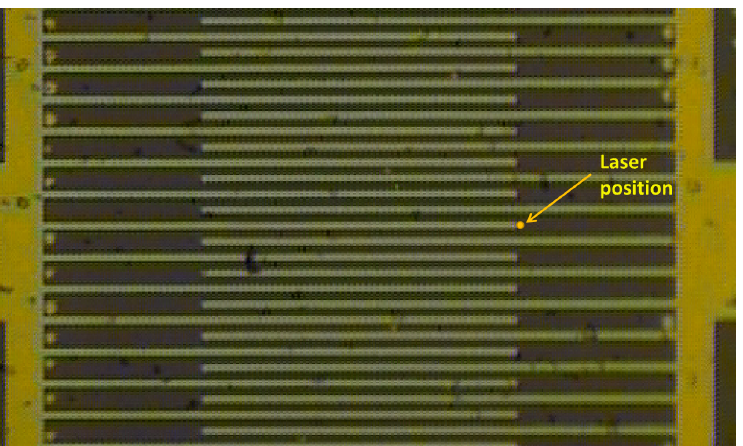
Figure 6. A microscopic image of the fabricated Bleustein–Gulyaev wave (BGW) IDT showing the location of the Laser Doppler Vibrometry (LDV) laser spot.